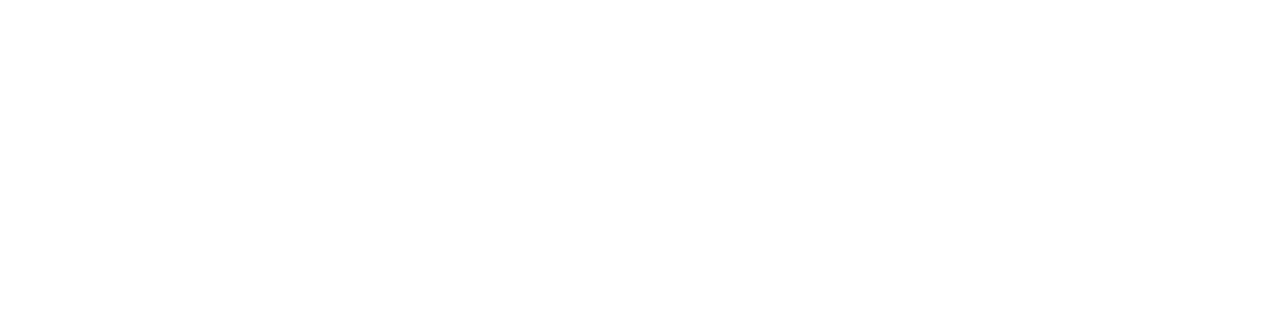
Frontiers in Materials |